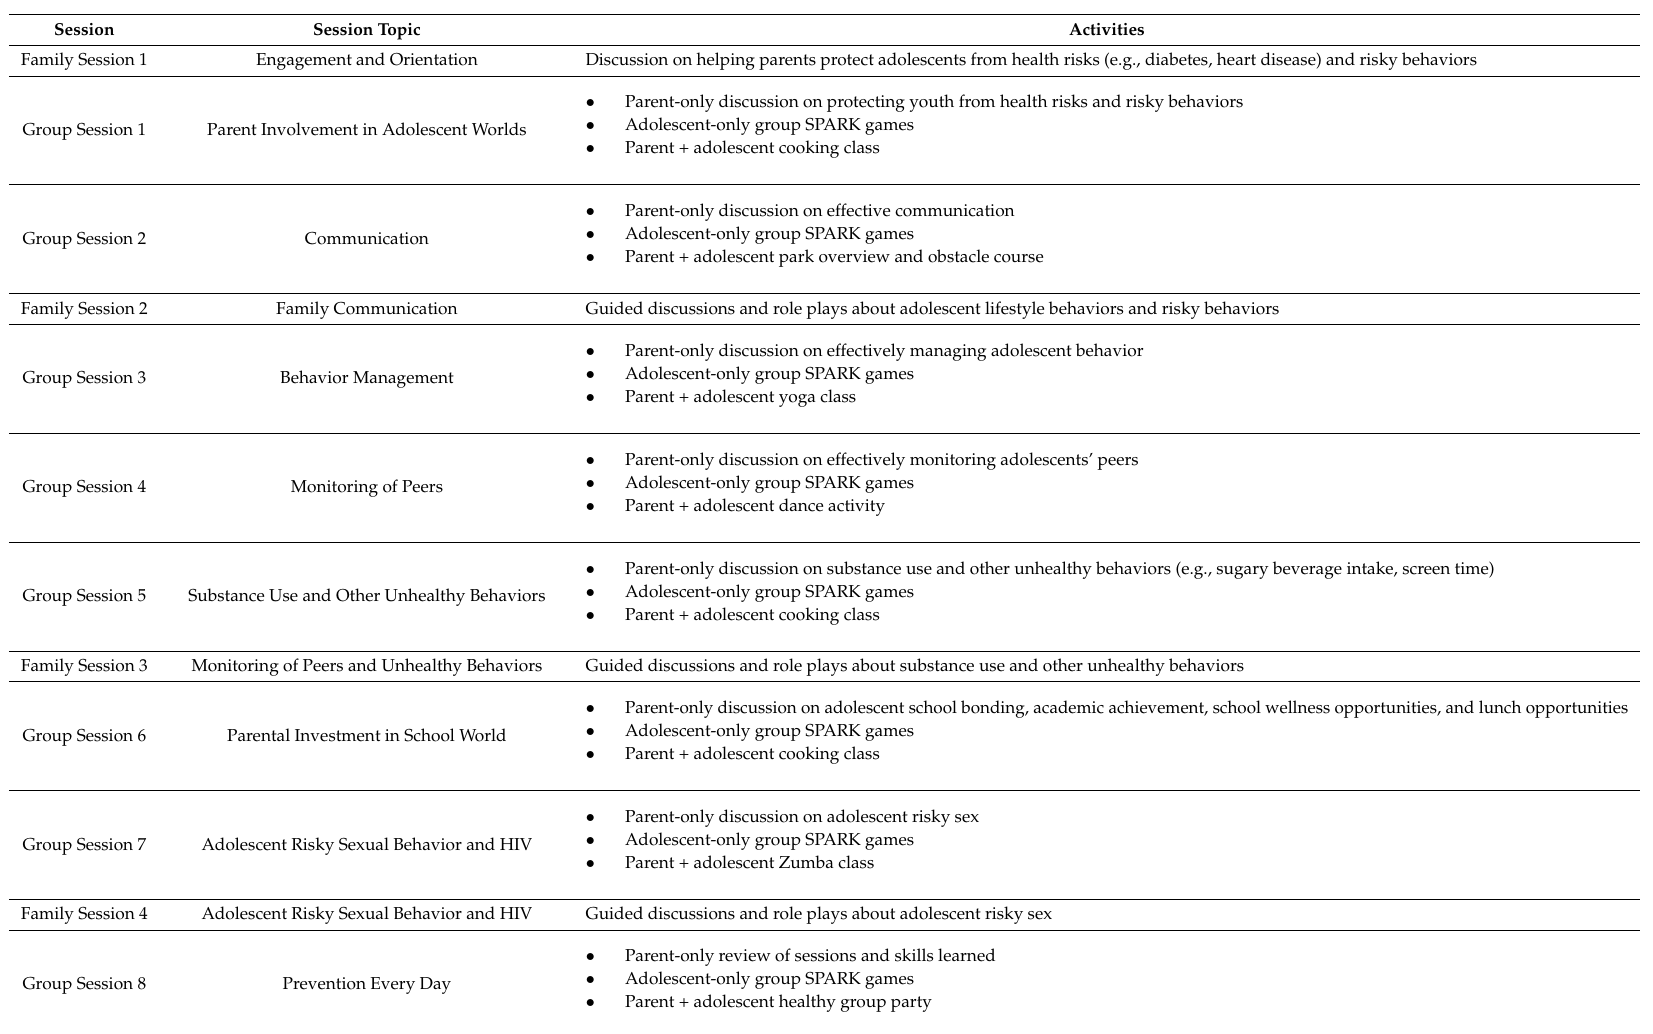
Table 2. Weekly Session Topics and